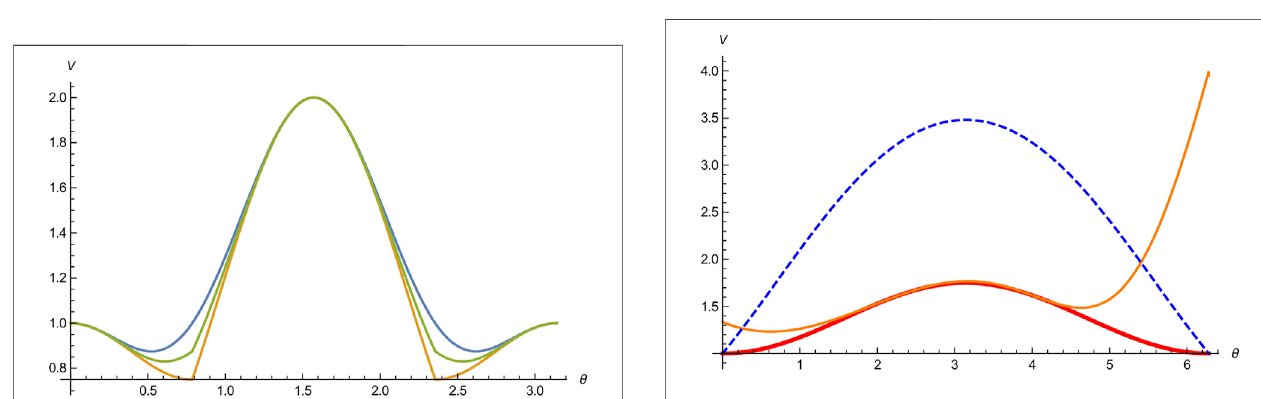
FIGURE4| Upper bounds of V ( A ) + V ( B ) forafamilyofspin-1/2 particles ρ ( θ ): the sum-form uncertainty relation V ( A ) V ( B ), our bound U the bound of Ref. [34] are depicted in red, blue, and orange